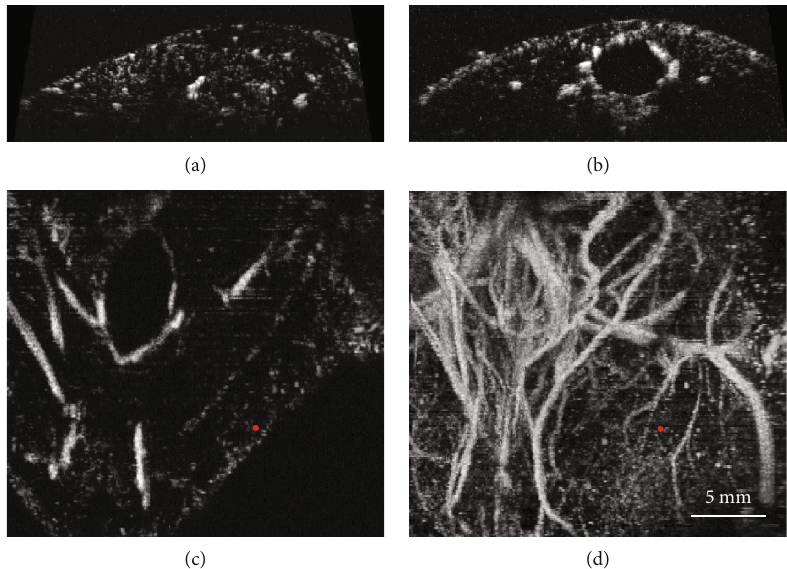
Figure 3: (a, b) Axial frames from control mice. (c) Coronal frame with a red dot to guide the reader ’ s focus for assessment. (d) is the maximum intensity projection image corresponding to